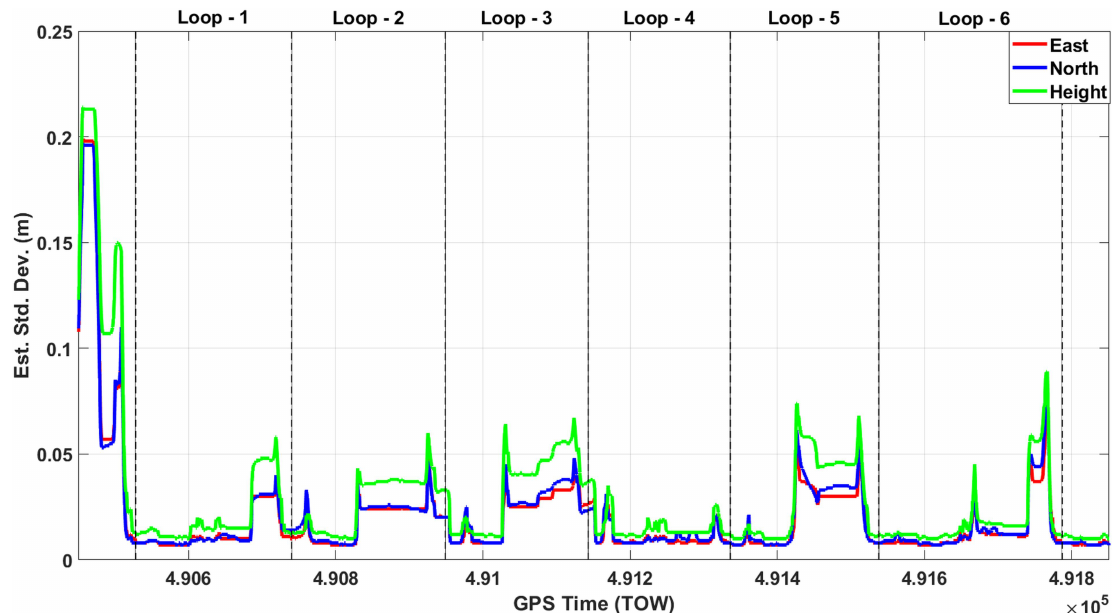
Figure 6. Estimated east, north, and height standard deviations of the GNSS/IMU integration.